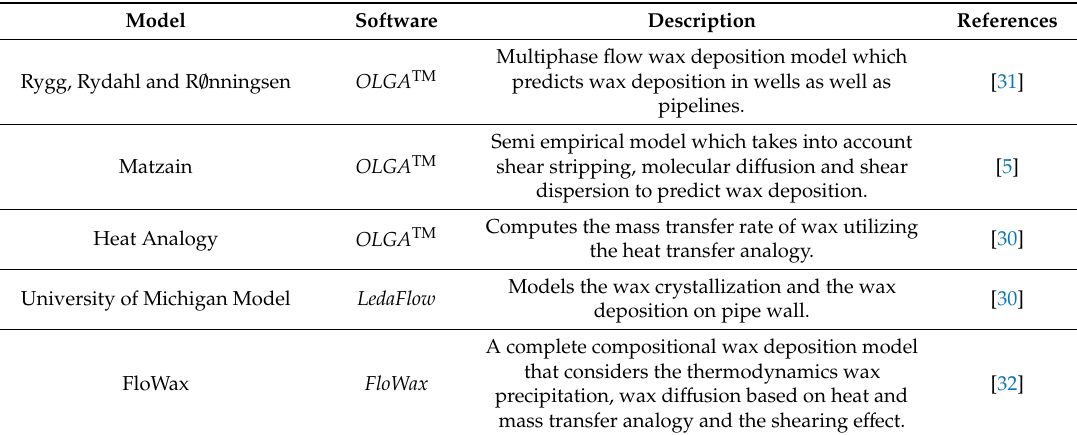
Table 1. Examples of models used in wax deposition